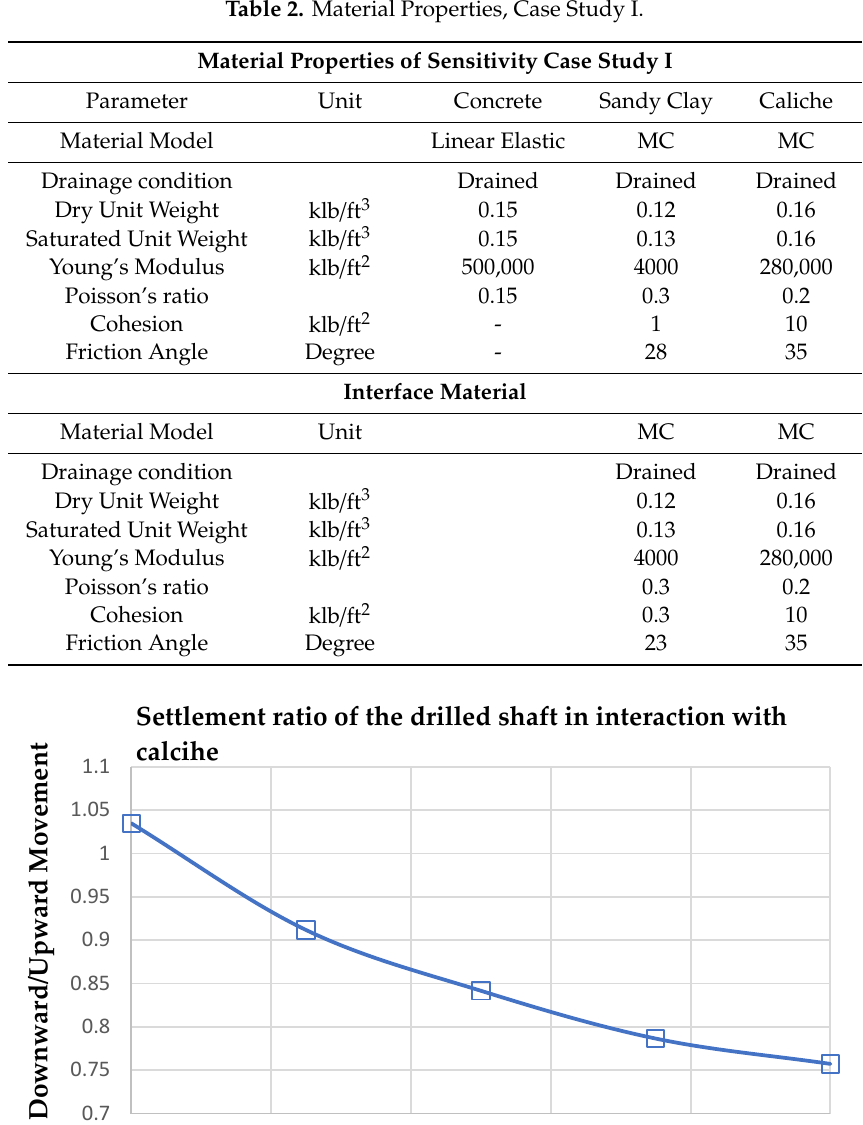
Table 2. Material Properties, Case Study I.